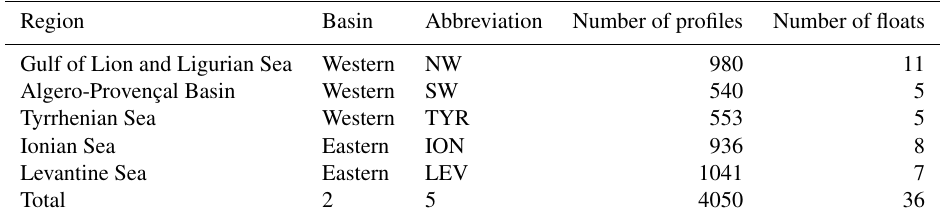
Table 1. Regions with the corresponding abbreviation and number of available floats and profiles represented in the Mediterranean BGC-Argo database used in the present